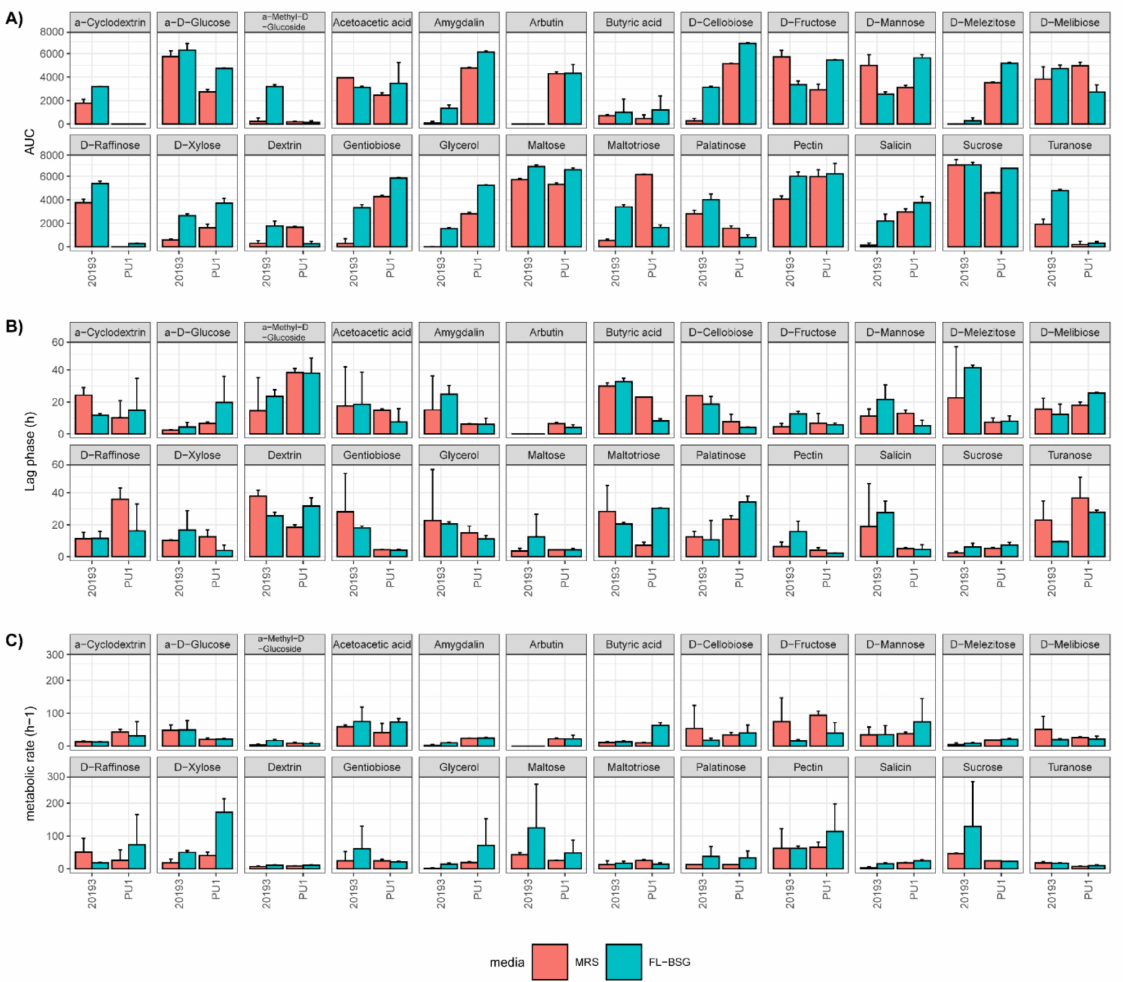
Figure 3. Metabolic parameters for selected substrates of Lactiplantibacillus plantarum PU1 and Leuconostoc pseudomesenteroides DSM 20193 ( A ) Area under the curve (AUC), ( B ) lag phase (h) and ( C ) metabolic tax (h − 1 ) cultured in Finnish brewers’ spent grain (FL-BSG) and MRS during 14 and 8 h respectively, at 30 ◦